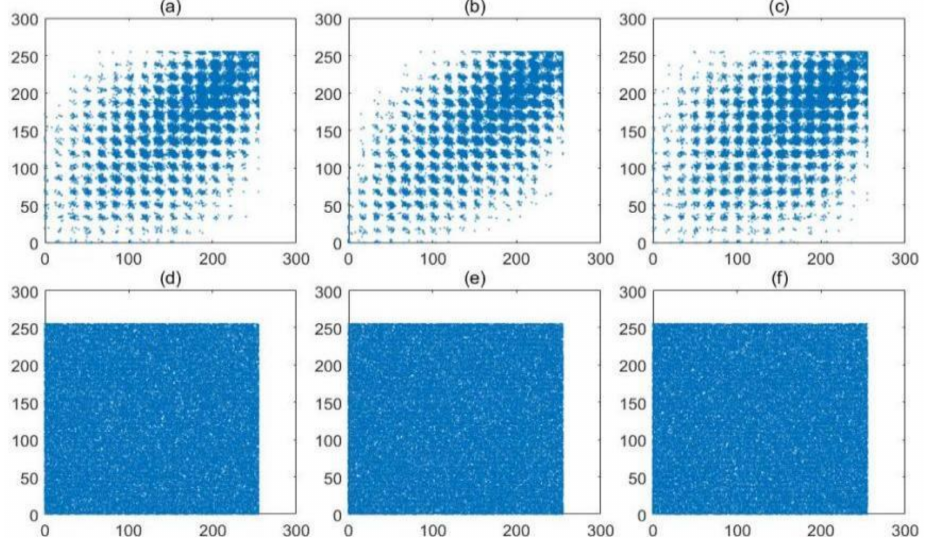
Figure 16. Correlation analysis of Horse image: ( a ) Adjacent pixel points of the plain-text image in horizontal direction; ( b ) Adjacent pixel points of the plain-text image in vertical direction; ( c ) Adjacent pixel points of the plain-text image in diagonal direction; ( d ) Adjacent pixel points of the encrypted image in horizontal direction; ( e ) Adjacent pixel points of the encrypted image in vertical direction; ( f ) Adjacent pixel points of the encrypted image in diagonal